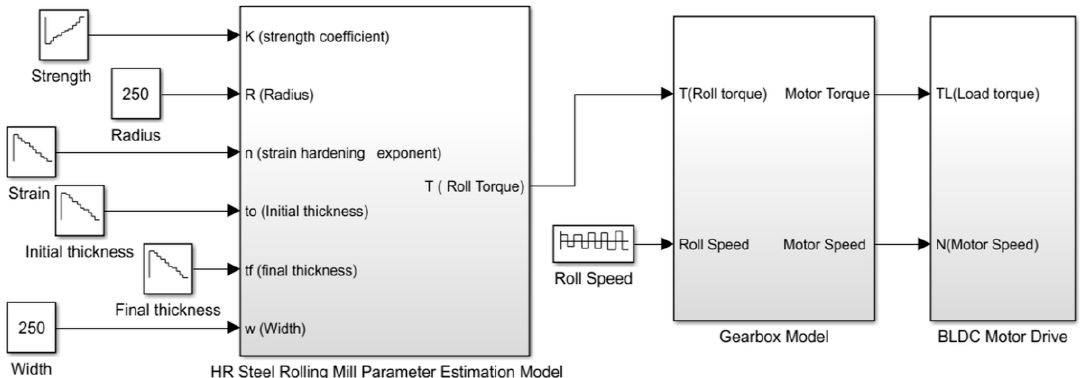
Figure 7. MATLAB/Simulink model of BLDC motor-drive system coupled with rolling process. Figure 7. MATLAB / Simulink model of BLDC motor-drive system coupled with rolling